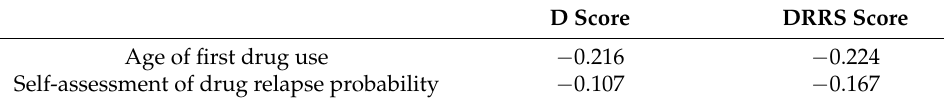
Table 9. Results of Spearman correlation